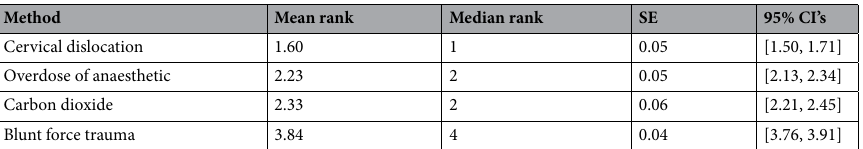
Table 3. Mean, median, standard error (SE) of the mean and 95% confidence intervals for each schedule 1 method ranked from 1 to 4 (1 = most preferred; 4 = least